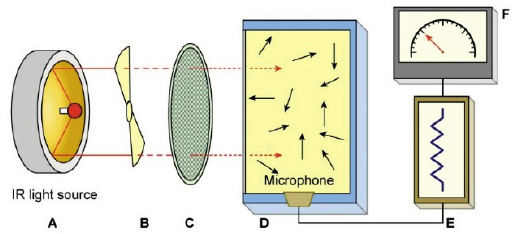
Figure 4. Schematic representation of the main components of a photoacoustic spectroscopy (PAS) analyser. ( A ) Reflector; ( B ) chopper; ( C ) filter; ( D ) photoacoustic chamber; ( E ) signal processor and ( F ) output display.